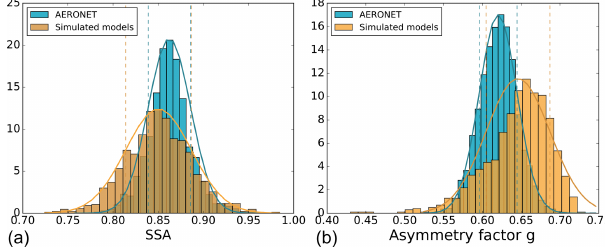
Figure 8. Histograms of the SSA (a) and asymmetry factor g (b) at 0.55µm simulated from a range of size distributions and refractive indices (orange) and retrieved by AERONET (blue) over southern Africa. Dashed lines represent the mean ± the standard